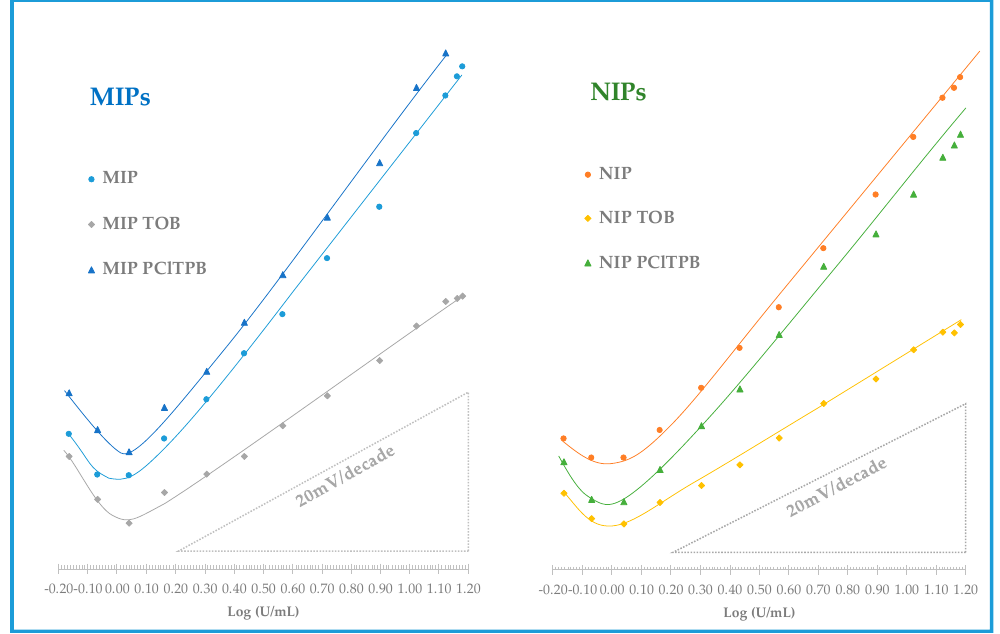
Figure 7. Potentiometric response of CA15-3 PVC membrane sensors with CA 15-3 standard solutions prepared in 4-(2-Hydroxyethyl)-1-piperazineethanesulfonic acid (HEPES) buffer, in pH 6.5, in the presence of a constant concentration of IL6.